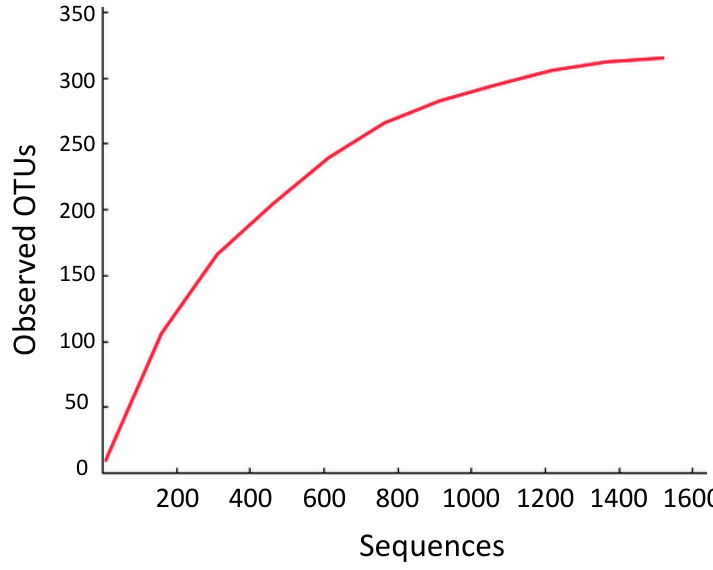
Figure 1. Species accumulation curve using operational taxonomic units (OTUs). Visualized using QIIME (Quantitative Insights into Microbial Ecology)